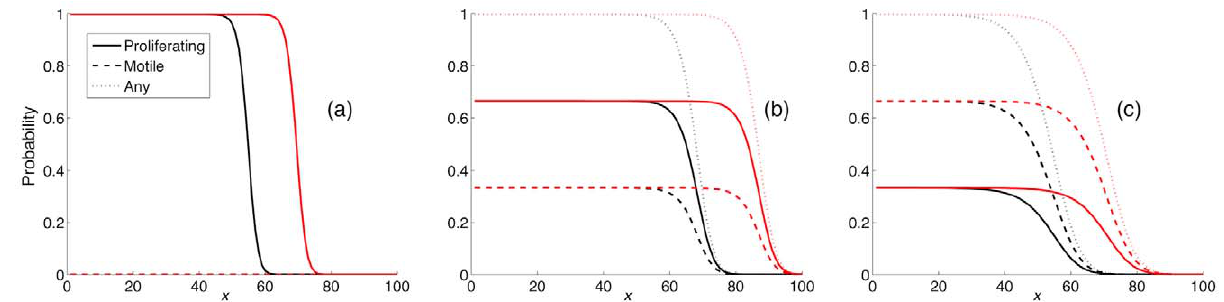
Figure 4. Numerical solutions of the continuum model. Solutions of the 1-dimensional continuum model (equation (3) and (4)) for three different values of the switching rates at T ~ 40 (black) and T ~ 50 (red). The initial condition was set to p ( x ,0) ~ exp ( { b x ) , b ~ 10 and m ( x ,0) ~ 0 . In (a) ( q p , q m ) ~ (10,0) , (b) ( q p , q m ) ~ (20,10) and in (c) ( q p , q m ) ~ (10,20) . All solutions exhibit similar characteristics with an invading front of cancer cells stretching into the healthy tissue, similar to the solutions of the Fisher equation (1). The similarity between the solutions at the two different time points clearly shows that our system exhibits travelling wave solutions.